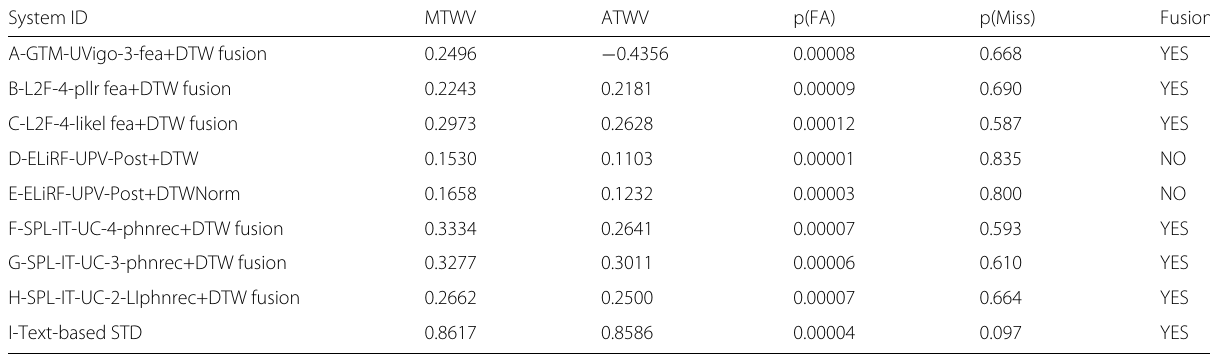
Table 11 System results of the ALBAYZIN QbE STD 2016 evaluation on the EPIC test data System